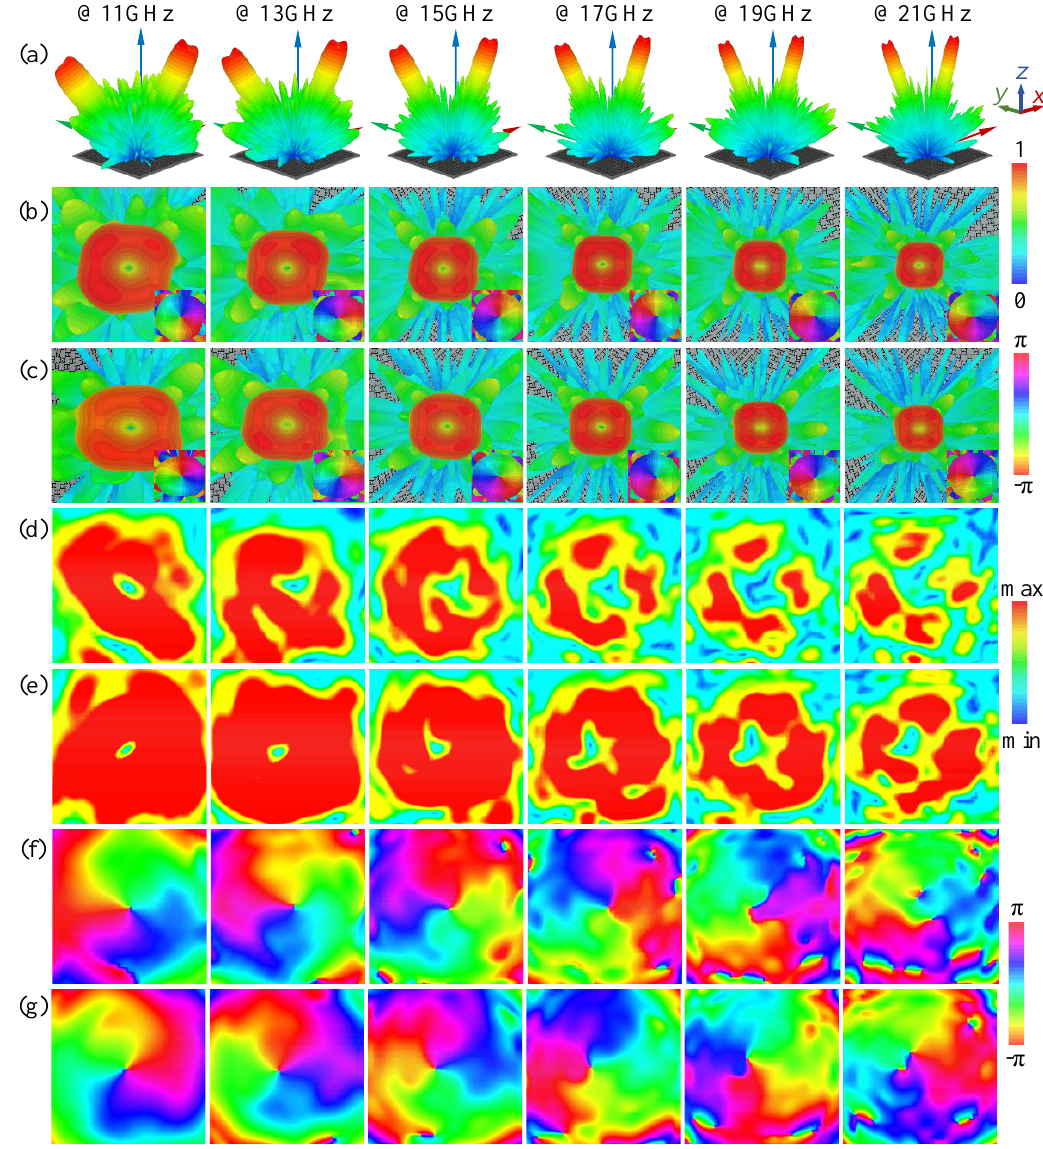
Figure 5. Simulated results at different frequencies. The far-field normalized 3D scattering pattern and corresponding phase in ( a ) upper half space, ( b ) fourth quadrant space, and ( c ) second quadrant space of the metasurface. The near-field amplitude of vortex wave with OAM mode ( d ) l = 1 in fourth quadrant space and ( e ) l = − 1 in second quadrant space. The near-field phase of vortex wave with OAM mode ( f ) l = 1 in fourth quadrant space and ( g ) l = − 1 in second quadrant